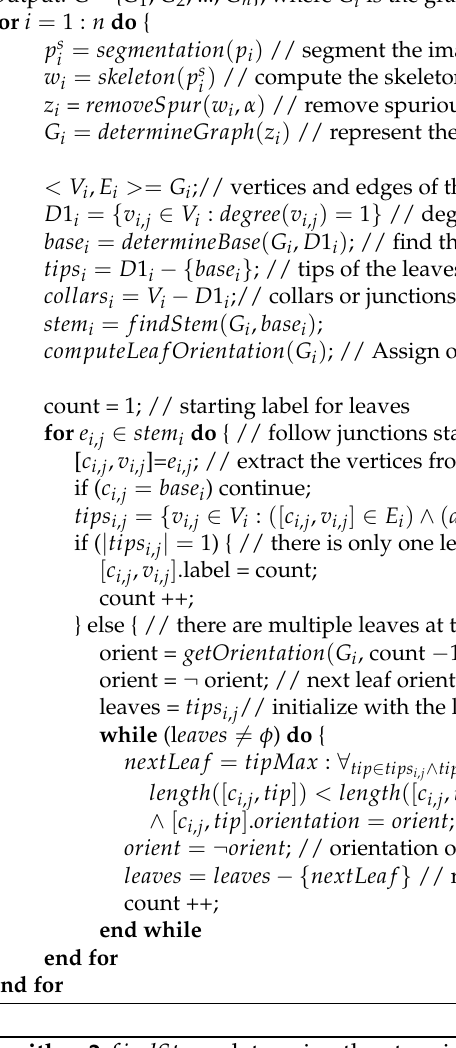
Algorithm 2 f indStem : determine the stem in a